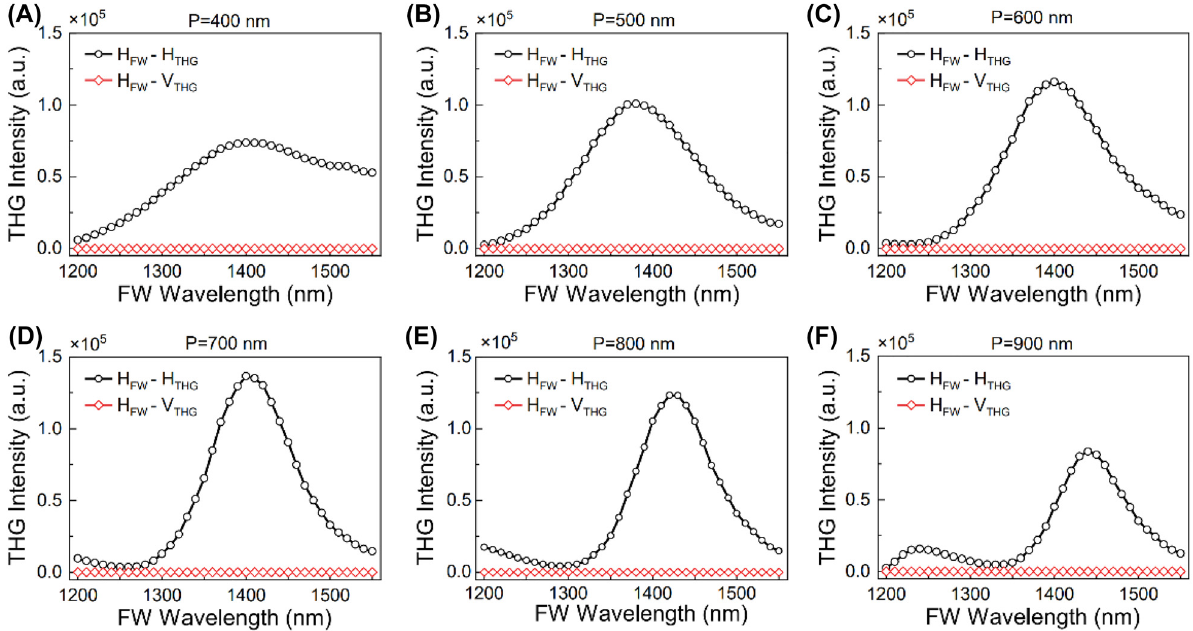
Figure 4: Calculated nonlinear optical responses of the gold/ α -Si hybrid metasurfaces. Wavelength dependent H (parallel to x -axis) and V (parallel to y axis)-polarized THG components were calculated under the pumping of H-polarized FW.